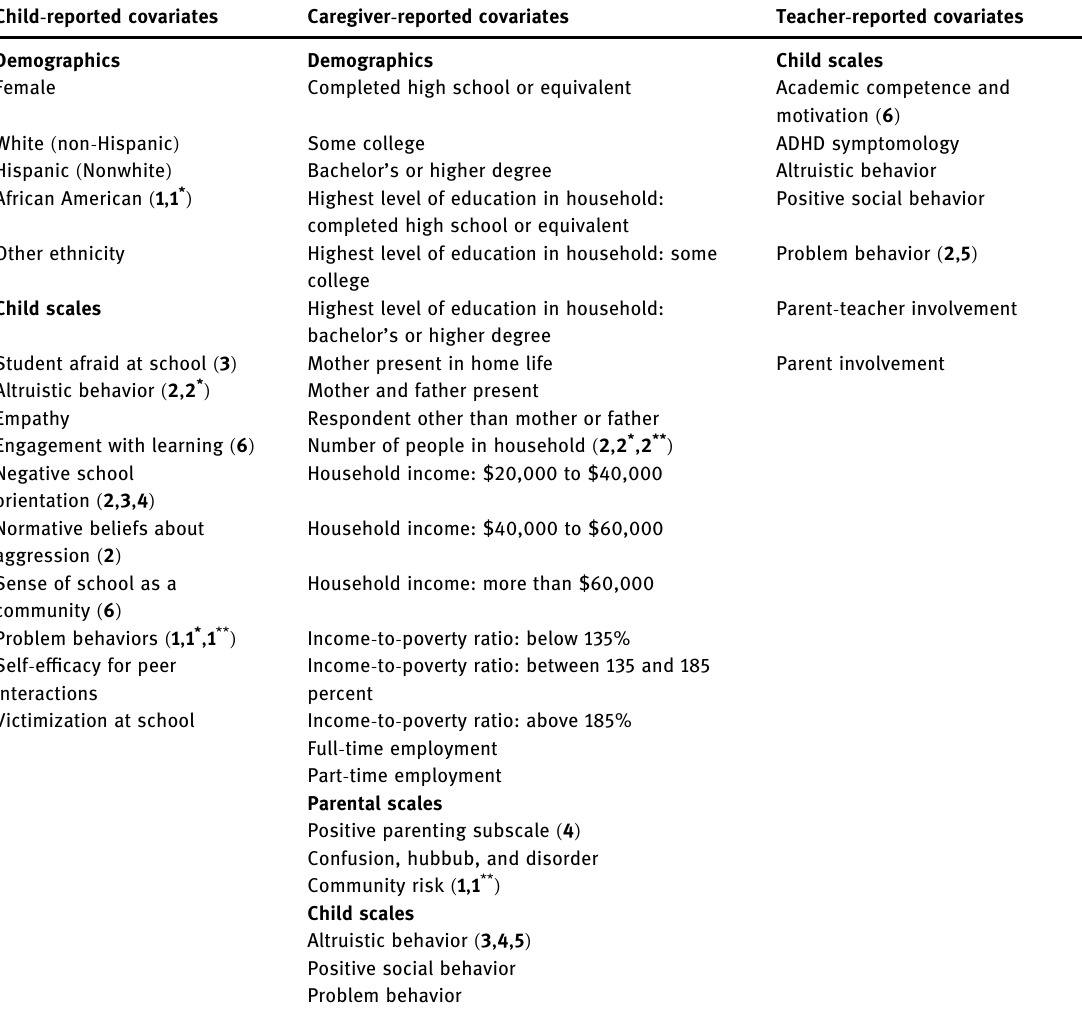
Table B2: List of all covariates and Lasso - selected covariates for the empirical analysis Child - reported covariates Caregiver - reported